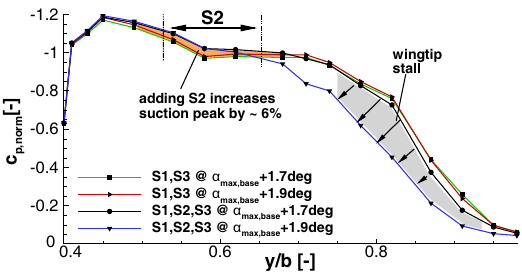
Figure 20. Effect of Segment S2 on the normalized pressure coefficient